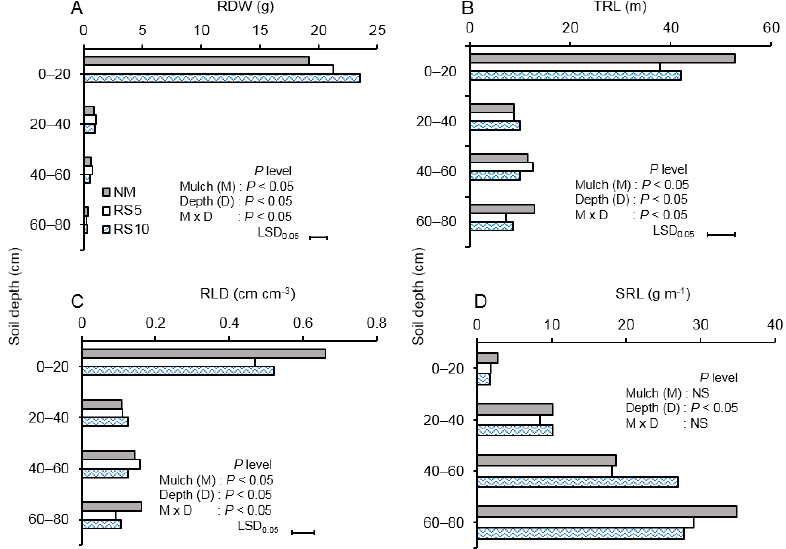
Figure 8. Effects of mulch treatments on root parameters at different soil depths at flowering (at 90 DAS) in 2018 – 2019: ( A ) mean root dry weight (RDW), ( B ) total root length (TRL), ( C ) root length density (RLD), and ( D ) specific root length (SRL). LSD 0.05 is the least significant difference in the interaction between mulch and depth. NM = no-mulch; RS5 = rice straw ~5 t ha − 1 ; RS10 = rice straw ~10 t ha − 1 .